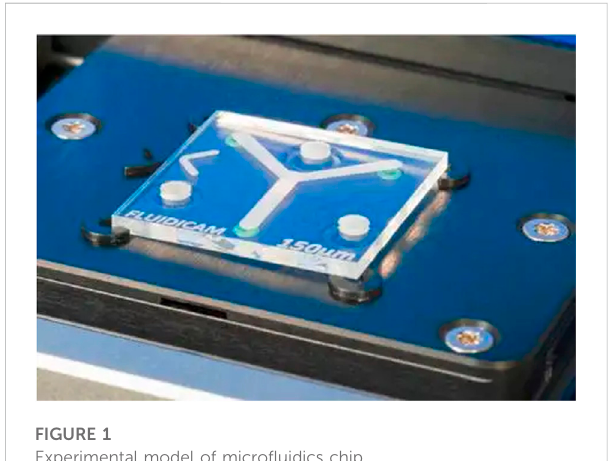
FIGURE 1 Experimental model of micro fl uidics